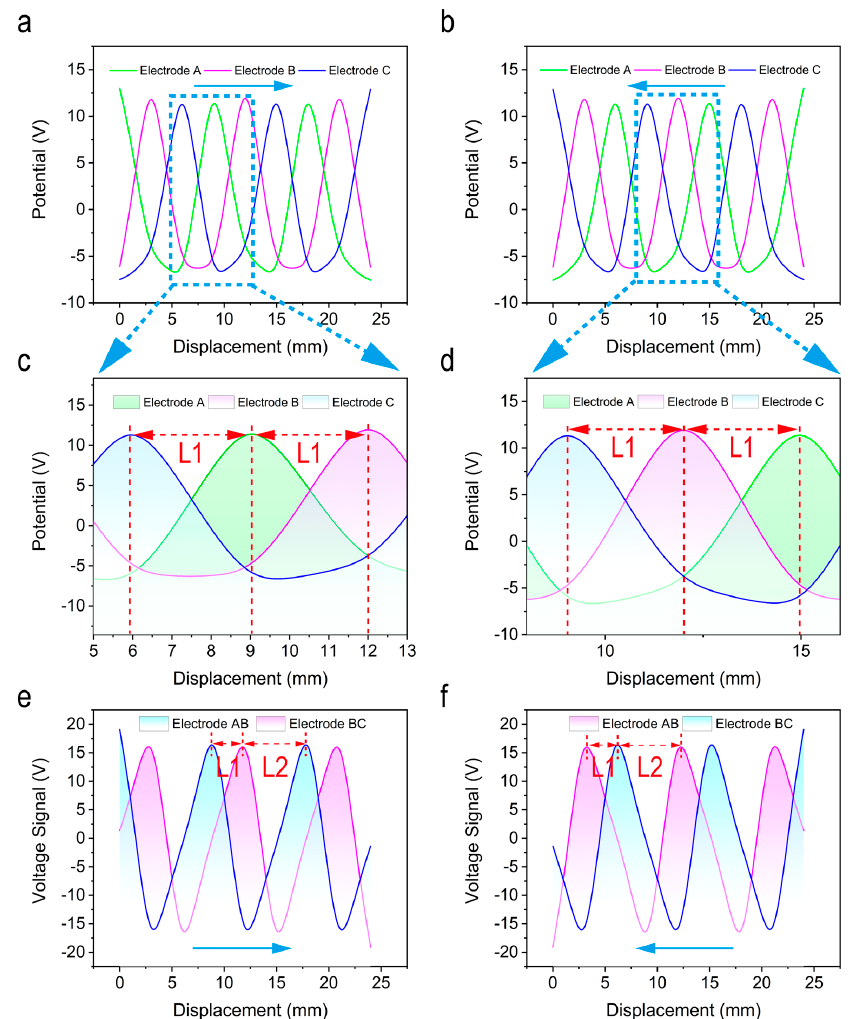
Figure 3. Simulation results of two detection modes of SPVS. ( a ) The theoretical calculation result of the slider sliding from left to right and ( b ) right to left under the first connection mode. ( c , d ) The enlarged view of the corresponding output signals in different directions. ( e , f ) Theoretical calculation results of the slider sliding from left to right and from right to left, respectively, under the second connection mode.